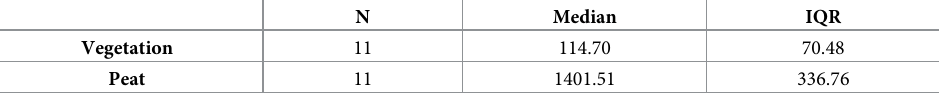
Table 2. Median carbon stock (Mg ha -1 ) and interquartile range (IQR) for above ground vegetation and peat soil. © University of Nottingham/ British Geological Survey © UKRI.